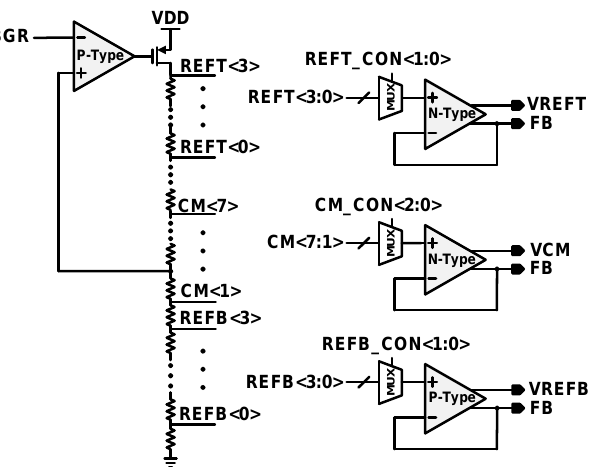
Figure 7. Architecture of the reference voltage generator.